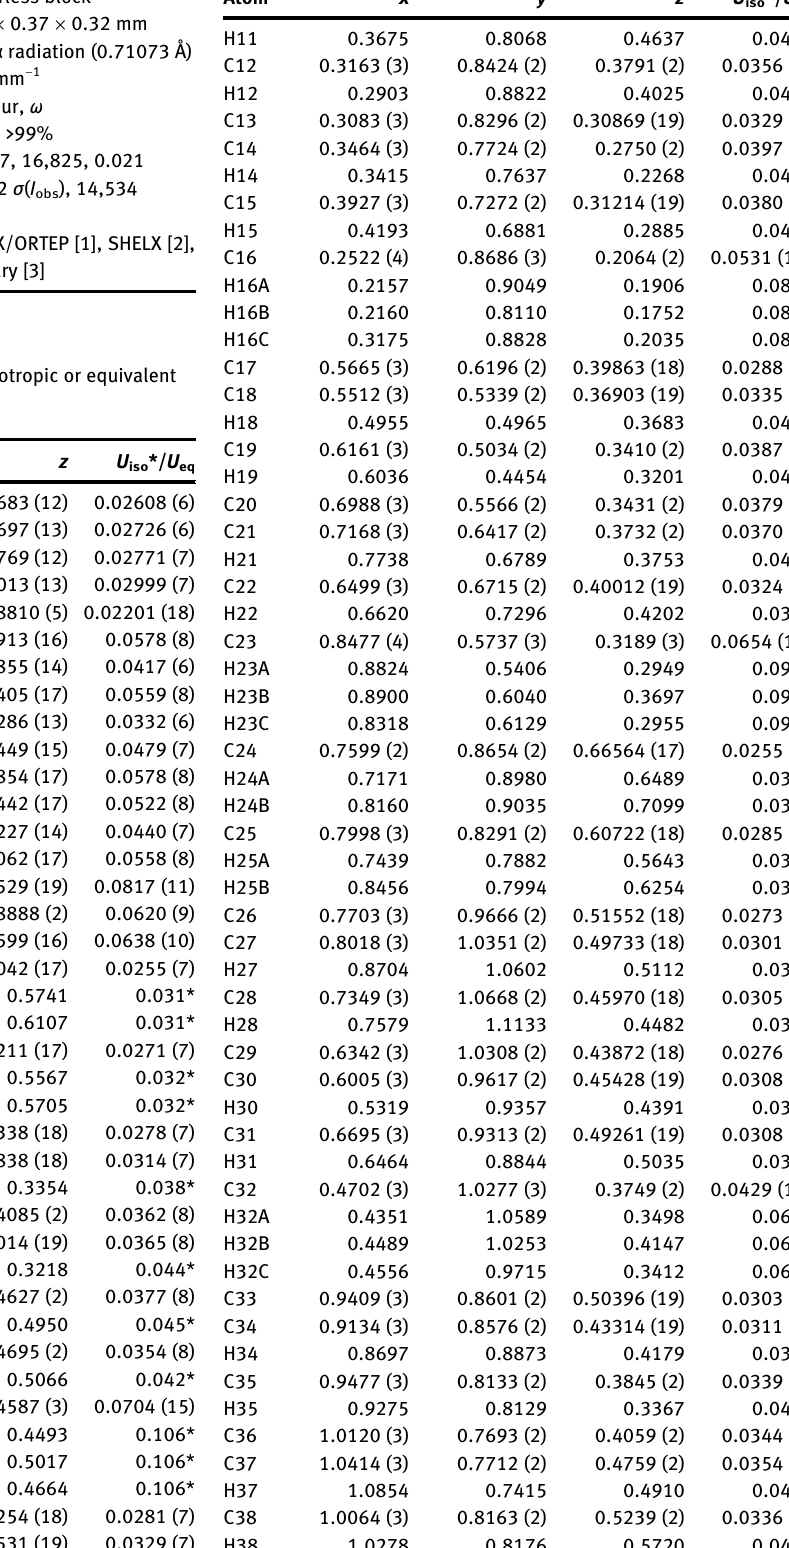
Table  : Data collection and handling. Crystal: